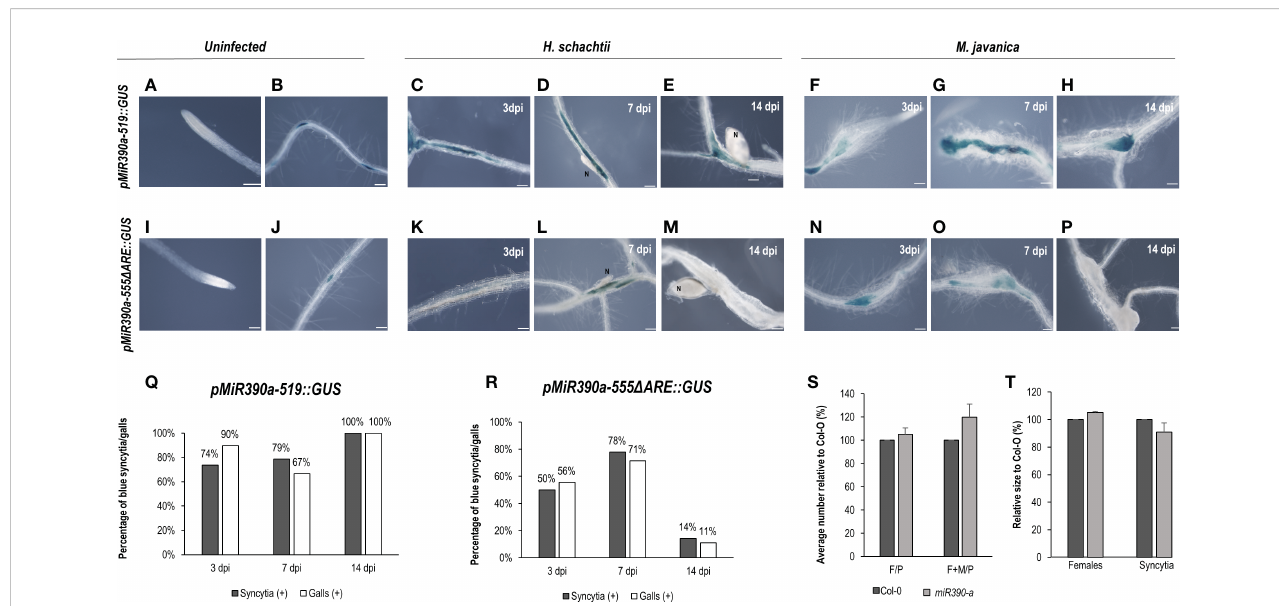
FIGURE 3 pmiR390a-519::GUS and pmiR390a-555 D ARE::GUS are active in the infection sites of Heterodera schachtii and Meloidogyne javanica in Arabidopsis The expression in uninfected tissues was centred in the lateral root primordia in both promoters pmiR390a-555, pmiR390a-555 D ARE::GUS (B, J) , but suppressed in the root meristem, used as positive controls ( A, I ; Dastidar et al., 2019). GUS-staining of Arabidopsis roots of the pmiR390a-519::GUS line infected by H. schachtii or M. javanica at 3, 7, and 14 days post inoculation (dpi; C – H , respectively). A deleted promoter version of an AuxRe element present in pmiR390a-555, pmiR390a-555 D ARE::GUS , showed GUS signal at 3, 7 dpi in both infection sites ( K, L, N – O , respectively), but it was nearly absent at 14 dpi ( M, P , respectively). Percentage of syncytia and galls with GUS-staining at 3, 7 and 14 dpi in pmiR390a-519::GUS (Q) and in pmiR390a- 555 D ARE::GUS (R) . A loss of function line miR390a-2 showed no signi fi cant differences in either the establishment of H. schachtii (S) or the female and syncytia size (T) as compared to the control Col-O (Student ’ s t-test; p <0.05). Number of females measured in Col-0, n = 20, in miR390a-2 , n = 23; number of syncytia measured, in Col-0, n = 18; in miR390a-2 , n = 19. Scale bars: 100 μm. At least 18 independent plants were assayed for GUS in each line and at least n ≥ 40 per line for the infection parameters of the miR390a-2 line and its corresponding control Col-0. Chi-square analysis, [ c ² (2, 47) = 4.22] and [ c ² (2, 41) = 3.43], indicated that the distribution of GUS-stained CN and RKN infection sites, respectively, in the pMIR390a-519::GUS line was not signi fi cantly different among the three infection stages, P <0.05. Chi-square analysis, [ c ² (2, 20) = 6.34] and [ c ² (2, 25) = 6.57], indicated that the distribution of GUS-stained CN and RKN infection sites, respectively in the pMIR390a-519::GUS line was signi fi cantly different among the three infection stages, P <0.05. At least three independent experiments per line were